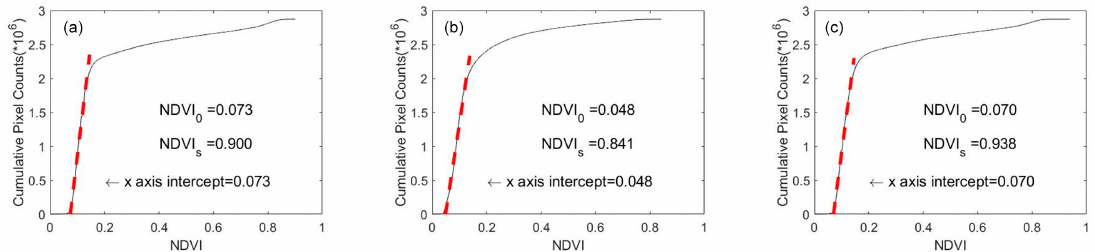
Figure 3. Cumulative NDVI frequency distribution for DOYs 195 ( a ); 227 ( b ); and 259 ( c ).